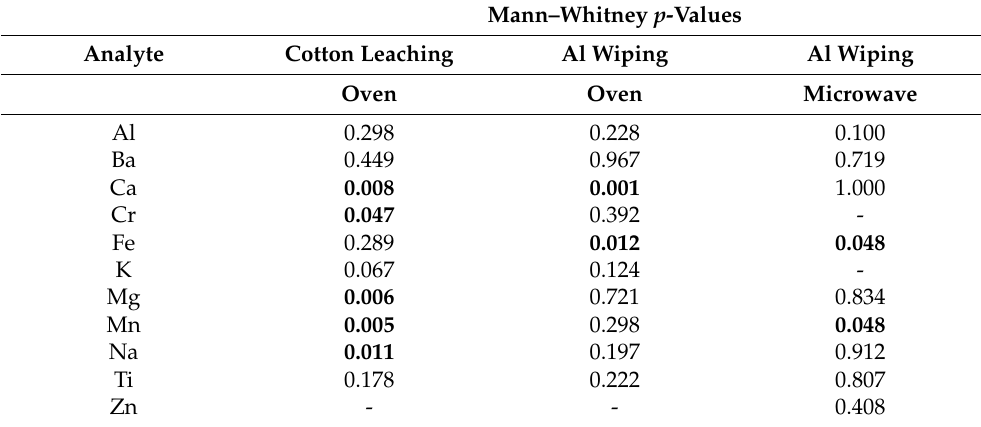
Table A4. p -values obtained with Mann–Whitney test ( p -values lower than 0.05 are in bold) for verifying if the leaching of cotton and the wiping of aluminium supports determined a significant increase in some analytes.